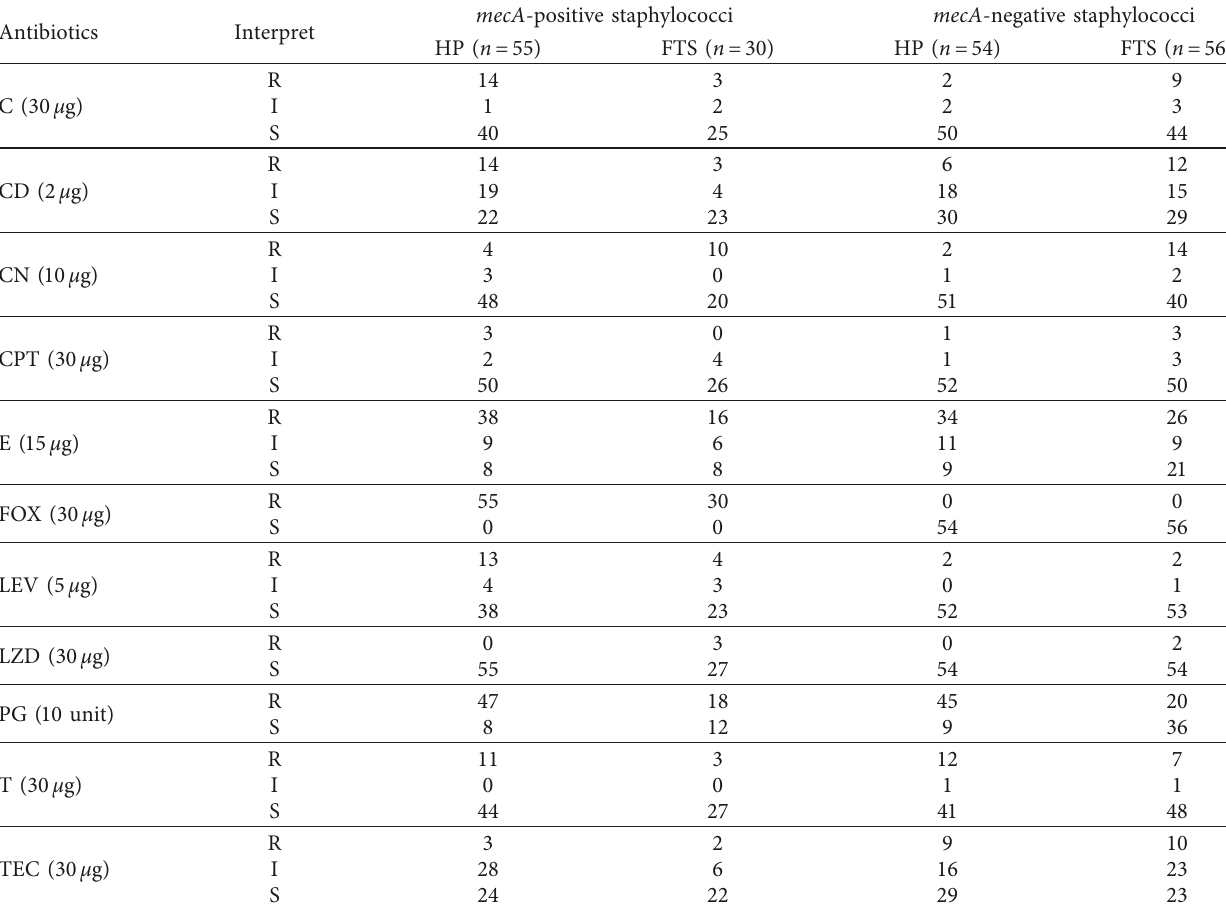
Table 1: Antimicrobial susceptibility profile of mecA -positive and negative staphylococci that were recovered from hospital personnel and frequently touched